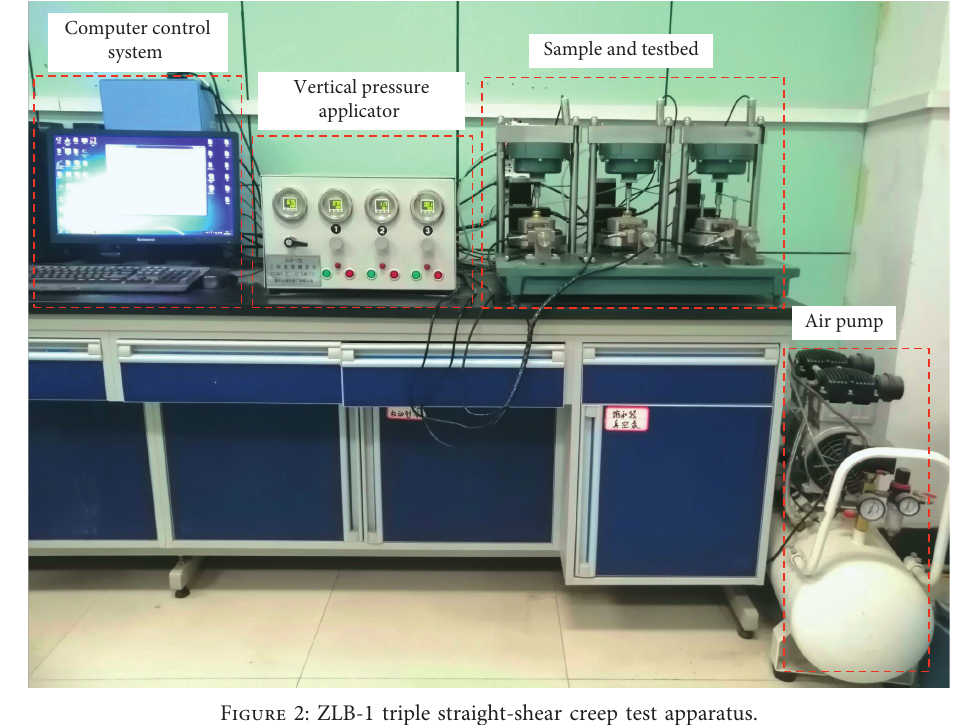
Figure 2: ZLB-1 triple straight-shear creep test apparatus.